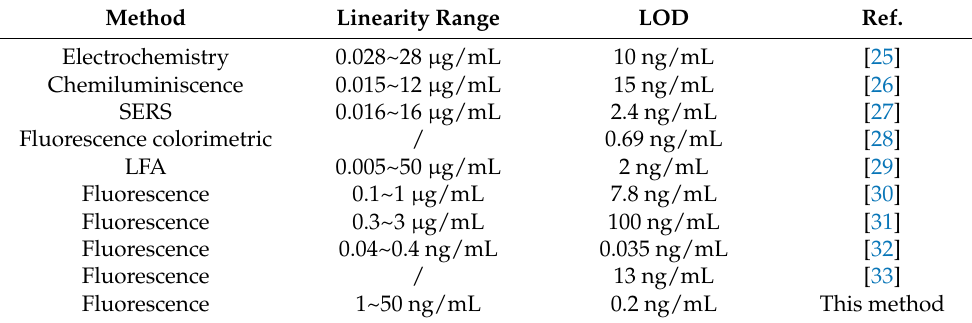
Figure 11. ( A ) The fluorescence recovery effect of DNA2-Ag NCs after adding different concentrations of glyphosate. ( B ) The relationship between the fluorescence intensity and different concentrations of glyphosate. Table 3. Comparison of different methods used for detecting glyphosate.